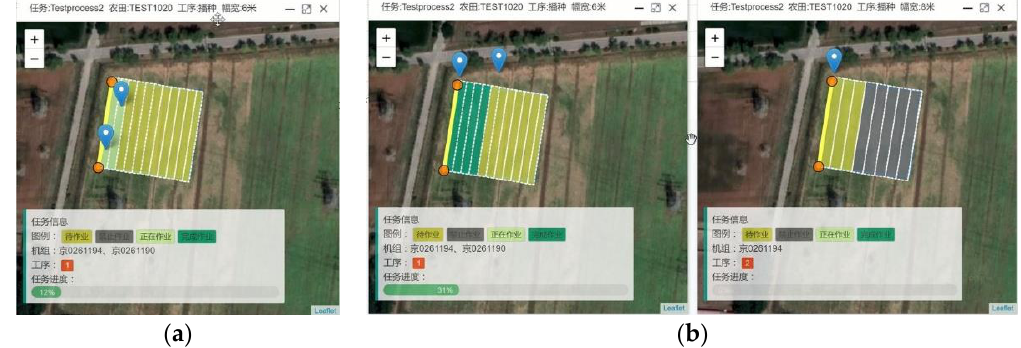
Figure 16. Monitoring interface of ( a ) ES1 and ( b ) ES2.